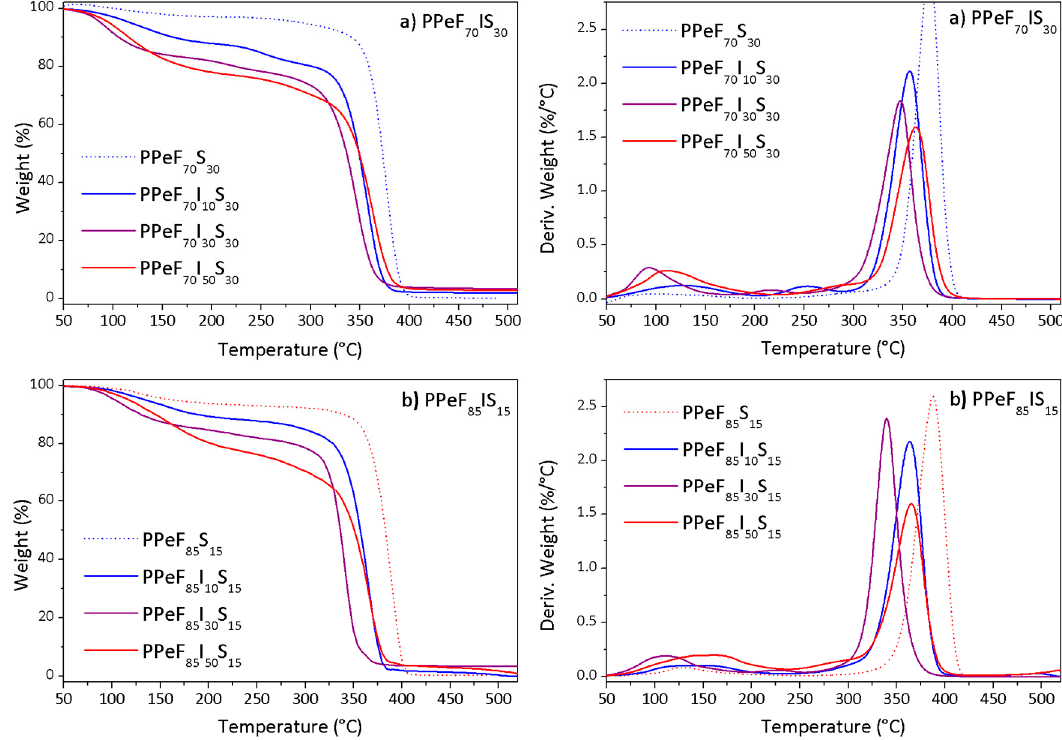
Figure 8. Weight % and derivative weight thermograms of polyesters ( a ) PPeF 70 IS 30 and ( b ) PPeF 85 IS 15 (N 2 flow, 10 °C·min − 1 ).